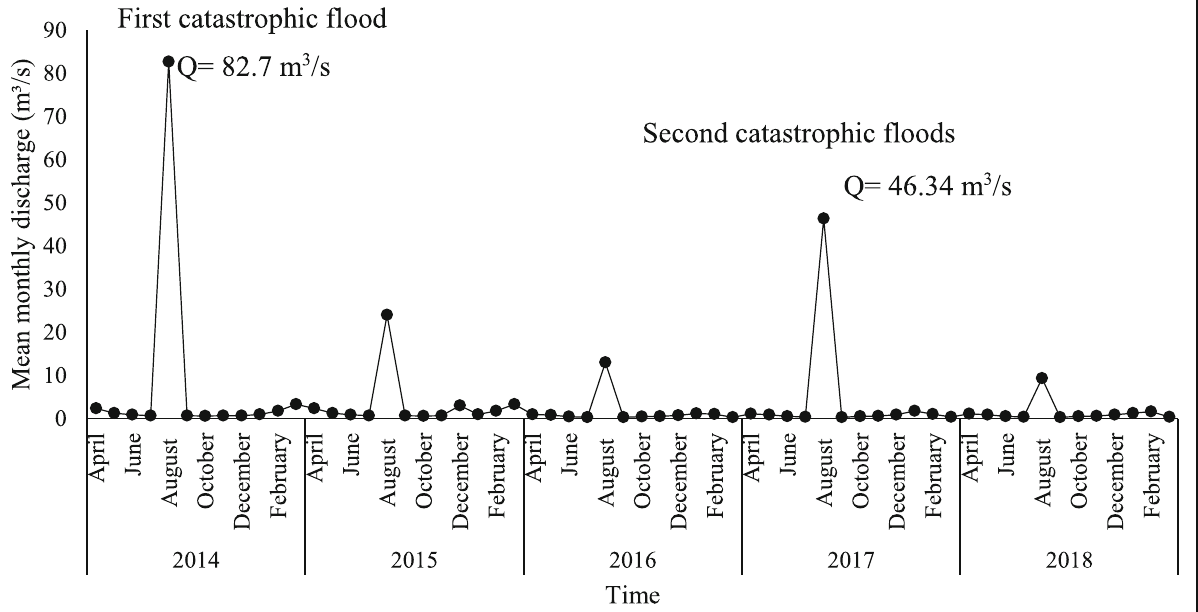
Fig. 3 Annual hydrograph (average of each month over the period of record available) for the Zarin Gol River. The figure shows intra-annual variability of discharge data and August constituted maximum discharge in 2014 (discharge (Q) = 82.7 m 3 /s)) and 2017 (discharge (Q) = 46.34 m 3